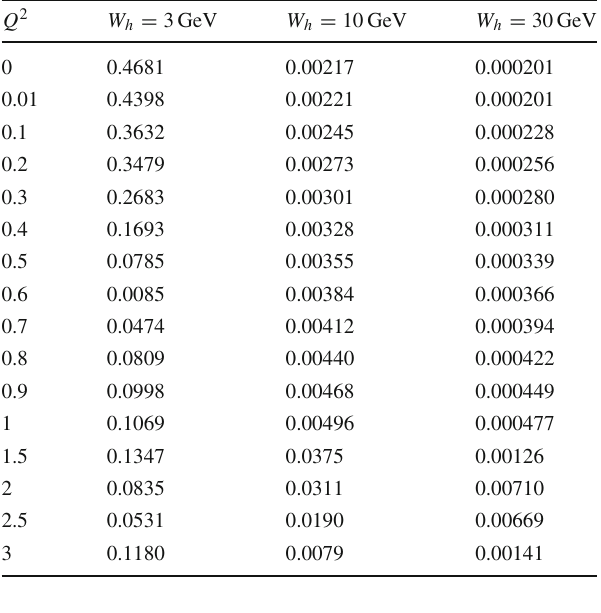
Table 2 Ratio r ( Q 2 ) defined in (14) as a function of Q 2 for